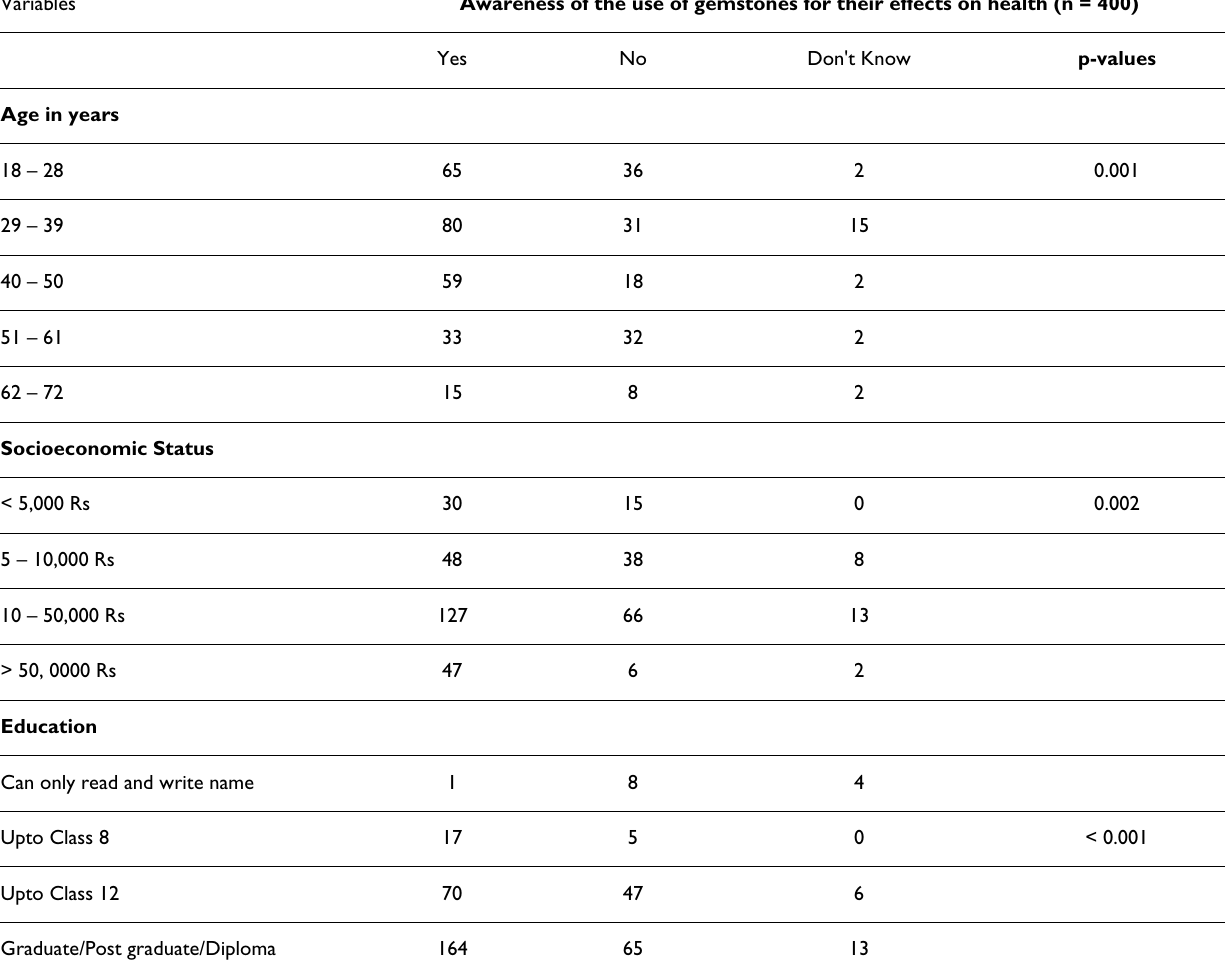
Table 8: Awareness of the use of gemstones for their effects on health